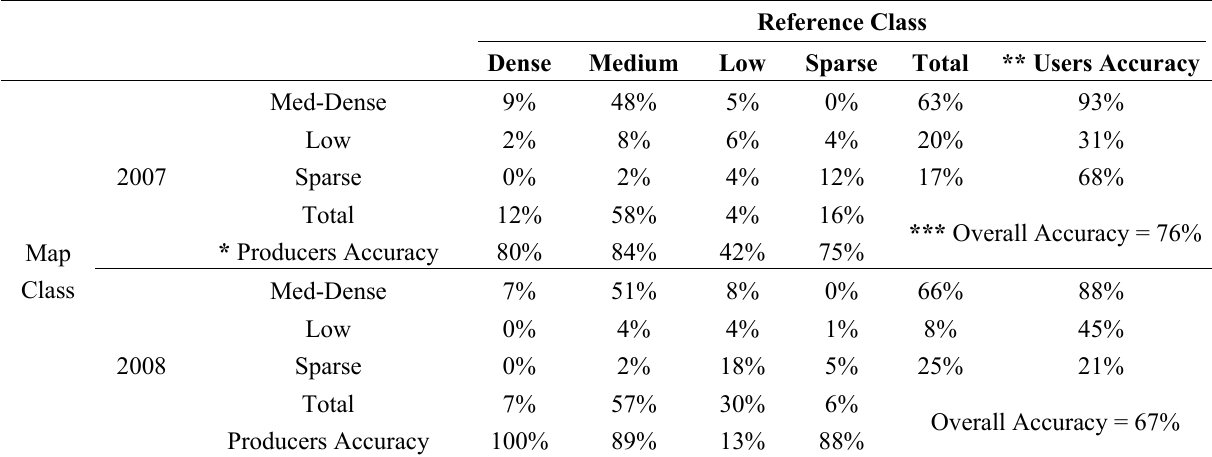
Table 3. Seagrass cover classification error matrix and accuracy assessment measures for each validation